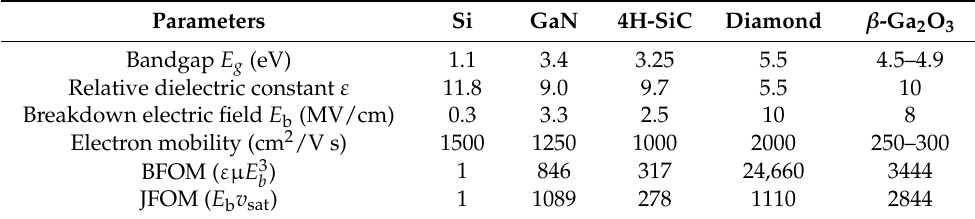
Table 1. Comparison of properties for β -Ga 2 O 3 and other semiconductors [36,39,45].